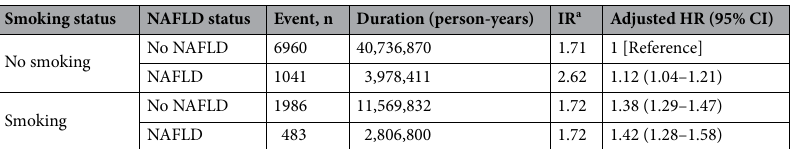
Table 3. Combined effects of non-alcoholic fatty liver disease and smoking on the risk of pancreatic cancer. HRs and 95% CIs were adjusted for age, sex, smoking status, alcohol consumption, physical activity, income, diabetes, pancreatitis, and body mass index. CI confidential interval, HR hazard ratio, NAFLD non-alcoholic fatty liver disease. a IR, the incidence rate per 10,000